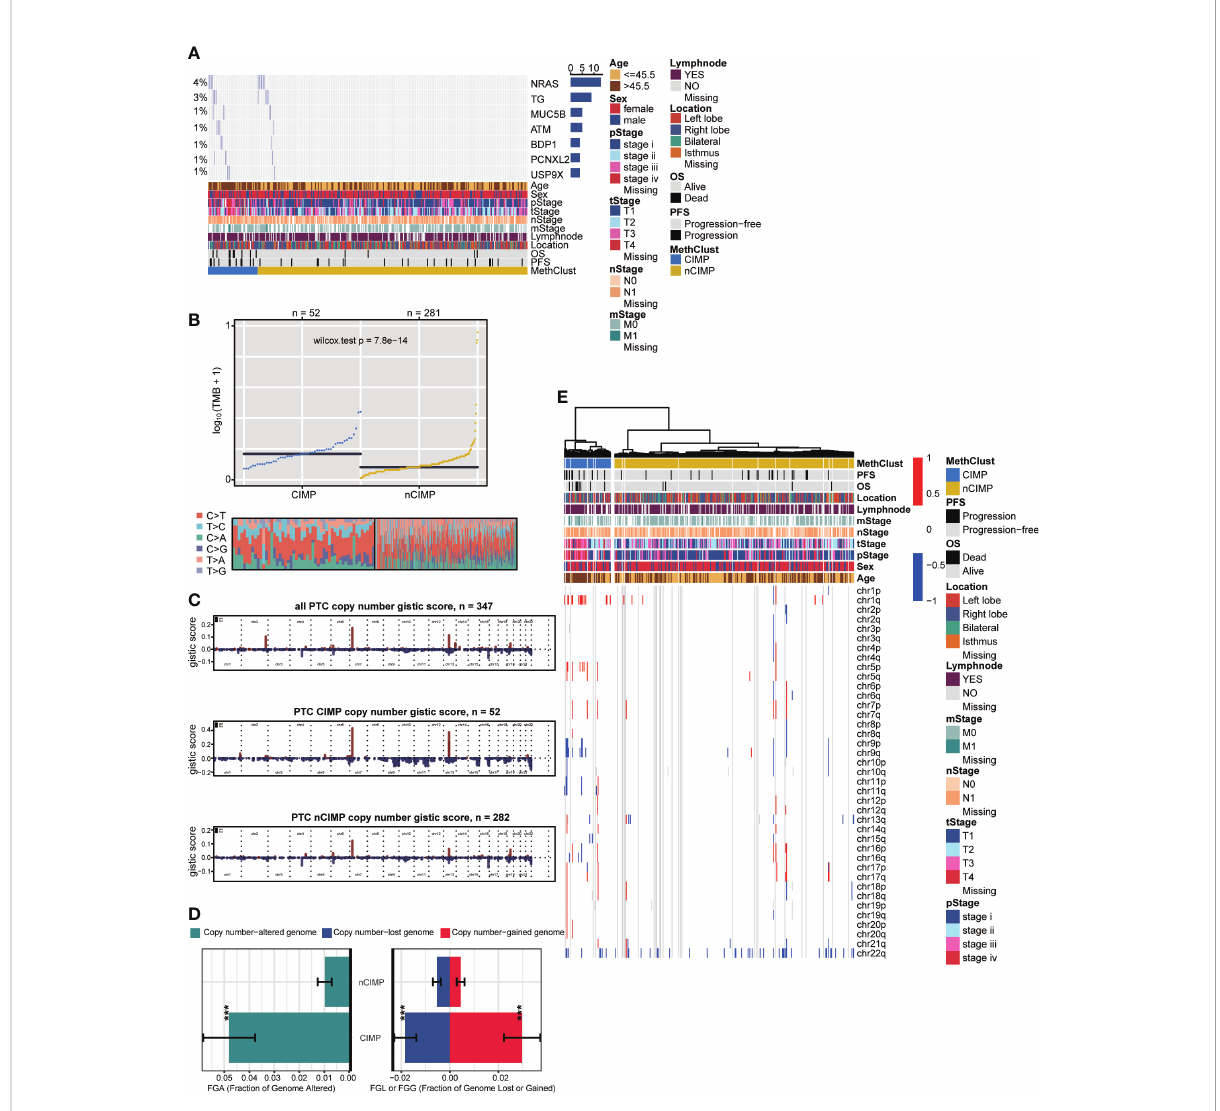
FIGURE 5 Genomic heterogeneity and chromosomal instability of CIMP. (A) OncoPrint showing the distribution of genes that were differentially mutated between two epigenetic phenotypes. (B) Distribution of TMB and TiTv (transition to transversion) between two epigenetic phenotypes. (C) Barplot showing the distribution of FGA and fraction genome gain/loss (FGG/FGL). Bar charts are presented as the mean ± standard error of the mean. (D) Comparison of focal-level CNA across entire cohort and in different epigenetic phenotypes, respectively. (E) Heatmap showing the distribution of arm-level CNA between two epigenetic phenotypes (***p <